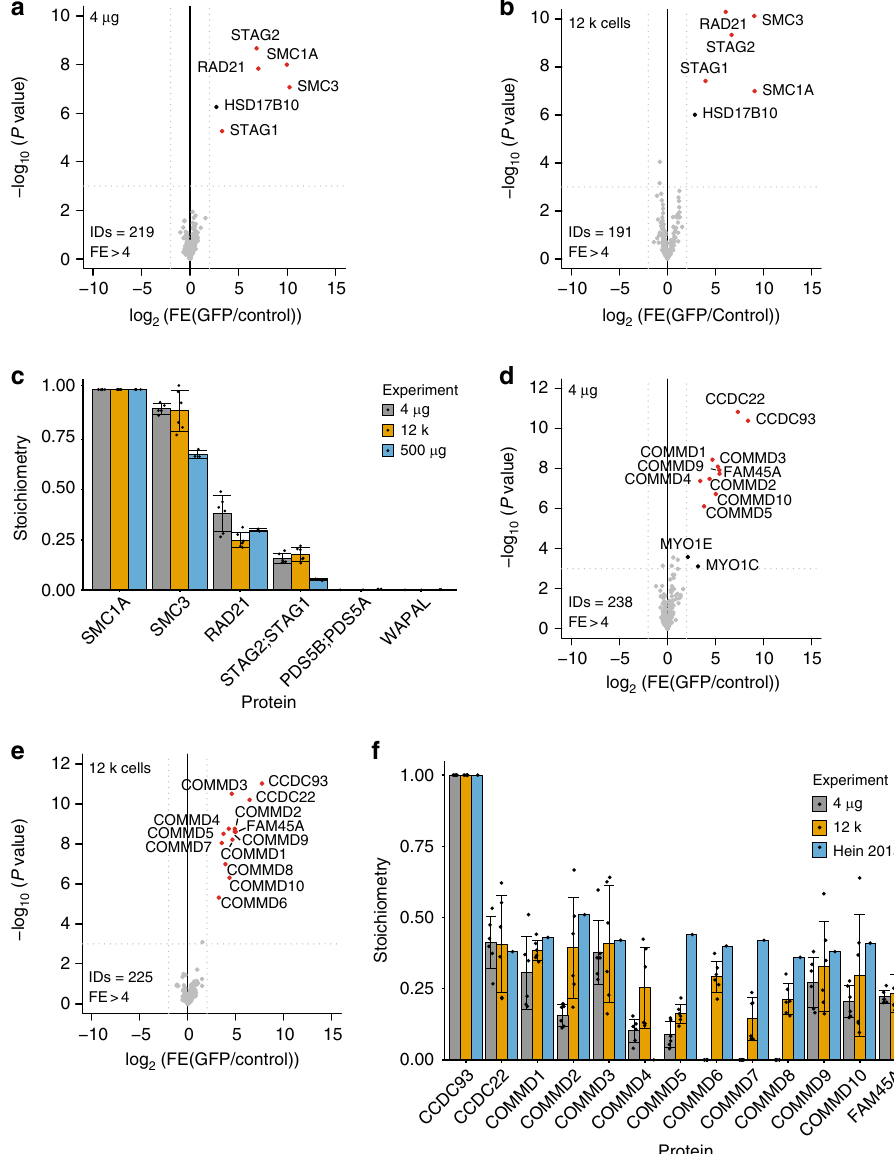
Fig. 2 Benchmark for on-chip AP-MS on low amounts of total extract using SMC1A-GFP and CCDC93-GFP baits. a , b Volcano plots from label-free micro fl uidic pull-downs for SMC1A-GFP bait using 4 µ g ( a ) or 12,000 cells ( b ). The enrichment of the bait and its partners as fold enrichment LFQ GFP over LFQ control ( x -axis) is plotted against the − log 10 transformed P value of the permutation based FDR corrected t test ( y -axis). ID refers to the total number of proteins reported and FE stands for fold enrichment. Dotted gray lines represent statistical cut-offs. Black dots identify signi fi cant proteins; red dots are signi fi cant proteins that are known interactors of the bait. HSD17B10 is a known contaminant of pull-downs using Dynabeads ® 33 . Each volcano plot presents n = 2 biologically independent experiments, each comprised of n = 3 technical replicates for PI-GFP and control extract. c Stoichiometry of the Cohesin subunits as compared to SMC1A for the experiments shown in panels a and b, as well as a 500 µ g microcentrifuge tubes-based pull-down shown as gold standard (data from Supplementary fi gure 1a). iBAQ values for each of the interaction partners of Cohesin were divided by the iBAQ values of the bait, so that is set to 1. Data display mean values ± s.d. Gray bars represent the stoichiometry of Cohesin complex as derived from for the 4 μ g input experiment, yellow bars for the 12,000 cells input experiment and light blue bars for the 500 μ g input microcentrifuge tubes-based pull-down. Black dots represent the individual data points. d , e Volcano plot from micro fl uidic pull-down for CCDC93-GFP bait using 4 µ g ( d ) and 12,000 cells ( e ). Dotted gray lines represent statistical cut-offs. Black dots identify signi fi cant proteins; red dots are signi fi cant proteins that are known interactors of the bait. MYO1E and MYO1C are known contaminants 33 . ID refers to the total number of proteins reported and FE stands for fold enrichment. Each volcano plot presents n = 2 biological replicates, each comprised of n = 3 technical replicates for PI-GFP and control extract. f Stoichiometry of the CCC complex subunits as compared to CCDC93 for the experiments shown in panels ( d ) and ( e ), using the pull-down performed by Hein et al. 10 as reference. iBAQ values for each of the CCC interaction partners were divided by the iBAQ values of the bait (set to 1). Data display mean values ± s.d. Gray bars represent the stoichiometry of CCC complex as derived from the 4 μ g experiment, yellow bars for the 12,000 cells experiment and light blue bars for microcentrifuge tube-based pull-down performed by Hein et al. 10 . Black dots represent the individual data points. Source data are provided as a Source Data fi